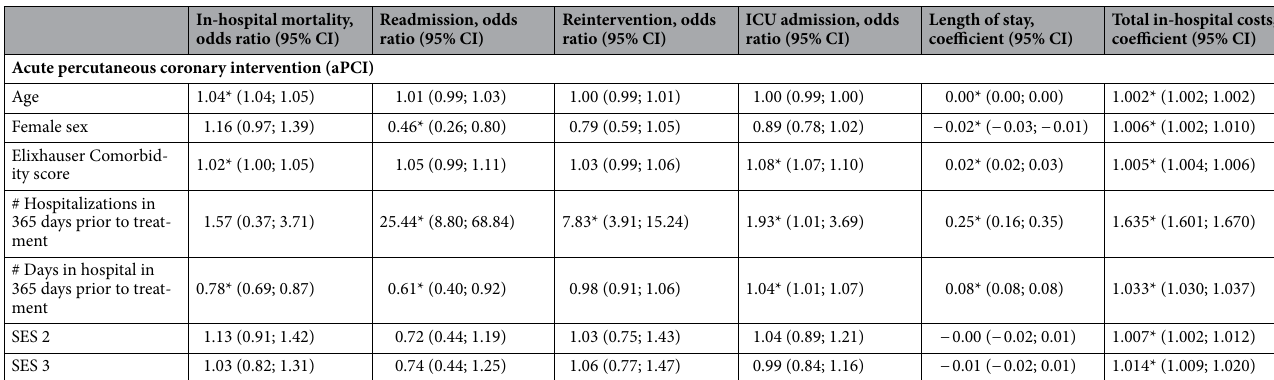
In-hospital mortality, odds ratio (95%